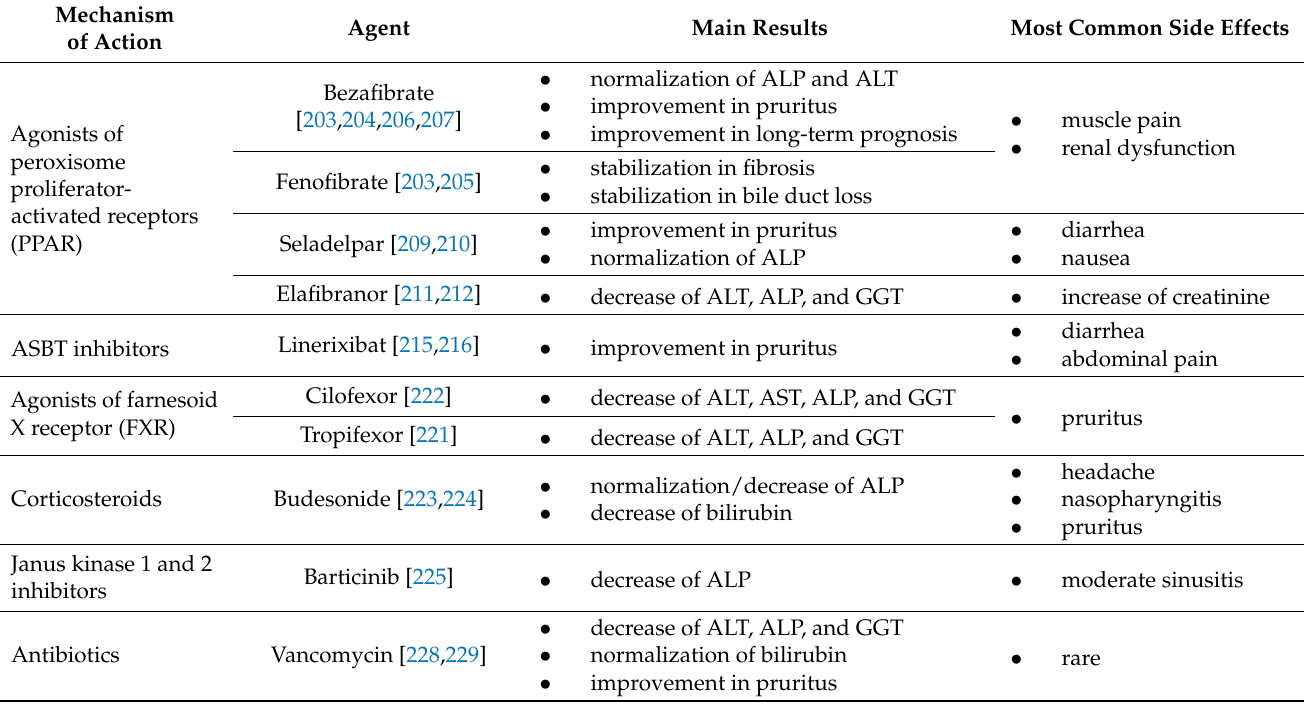
Table 1. Emerging therapies in PBC and PSC